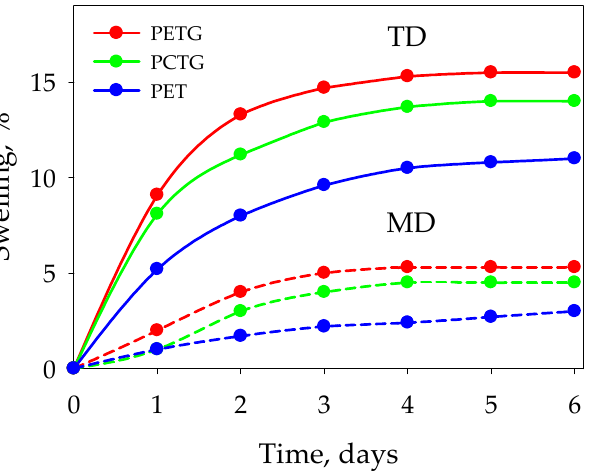
Figure 5. Material swelling during the ester sorption. MD—machine direction, TD—transverse di- rection.